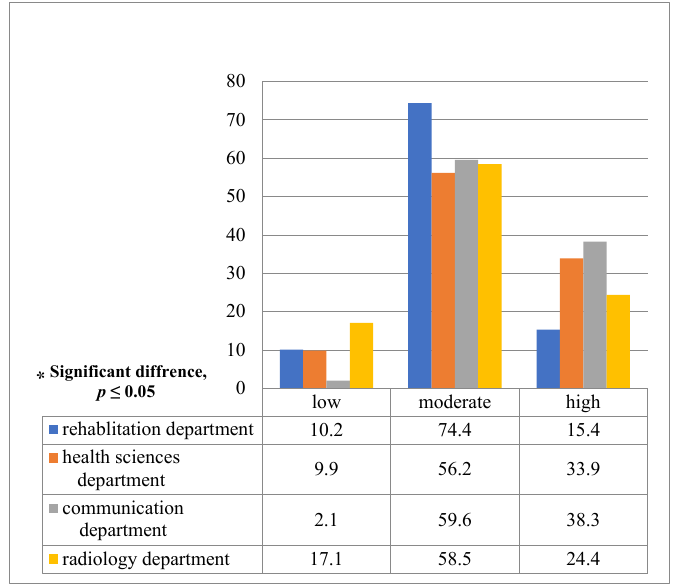
Figure 3. Comparison of the percentage of PRCA categories between students from 4 different academic departments ( p value = 0.02